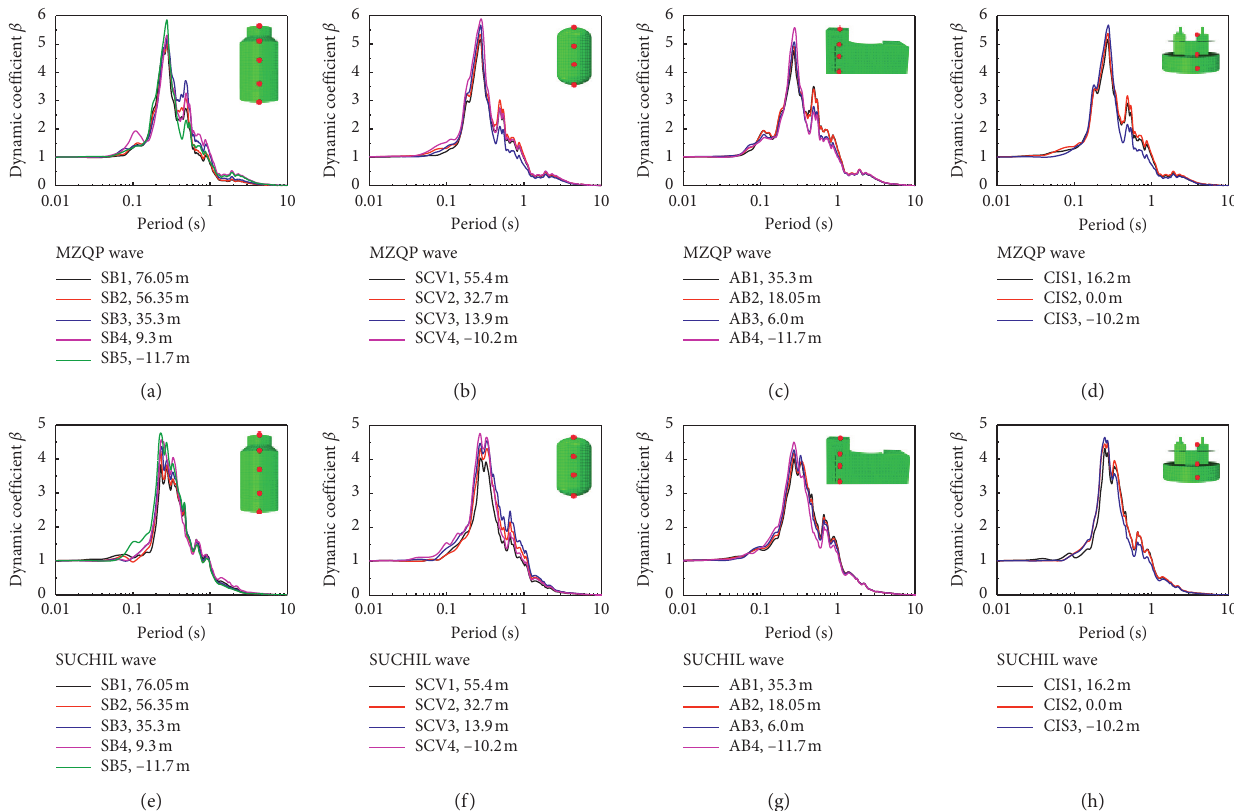
Figure 12: Changes of the FRS with the height of the nuclear island